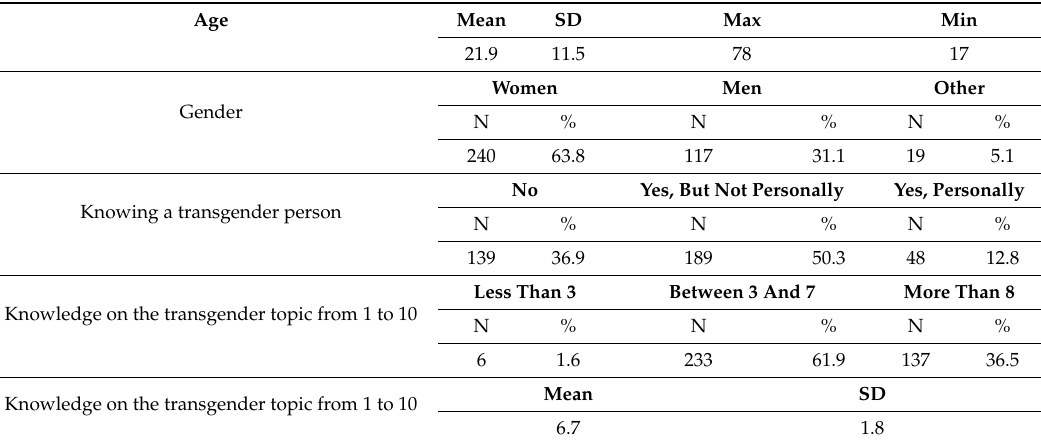
Table 1. Means, standard deviations, and percentages of the sample in terms of age, gender, knowing a transgender person, and knowledge of the transgender